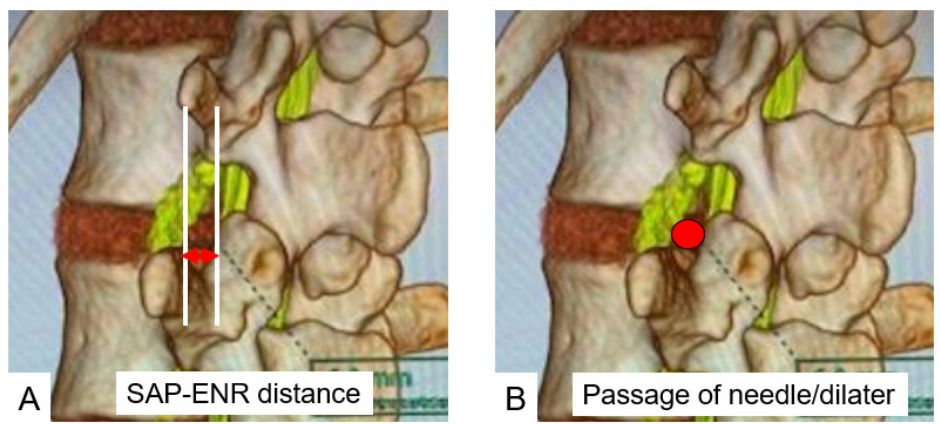
Figure 4. ( A ): SAP-ENR distance. ( B ): Passage of needle and dilater. A red arrow indicates SAP-ENR distance and a red dot shows passage of needle/dilater.